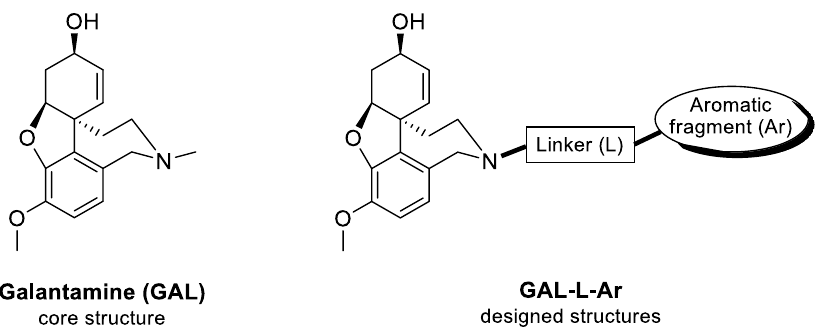
Figure 2. Common structure of the designed galantamine derivatives (GAL-L-Ar).